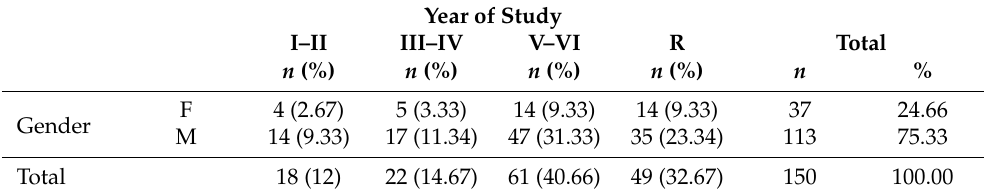
Table 1. Subject distribution by year of study and gender.